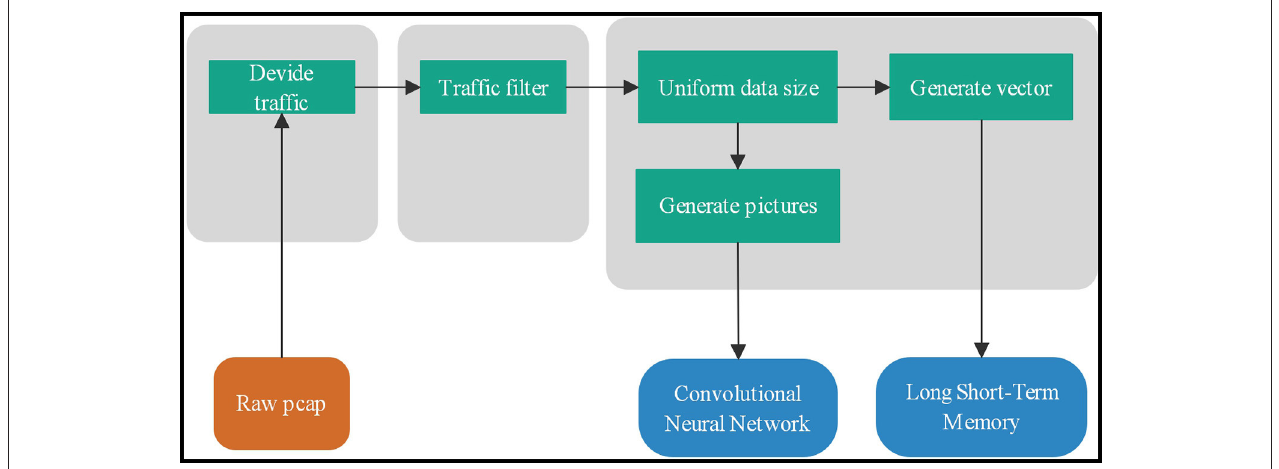
FIGURE 2 | Network traffic data packet processing process: flow division, flow filtering, uniform size and classification.